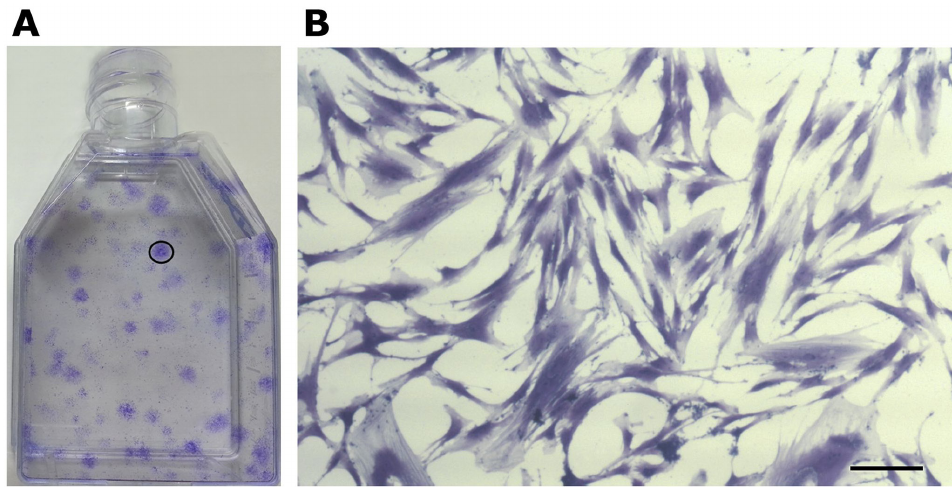
Figure 1. Fibroblast colony-forming unit (CFU-F). Bone marrow cells were plated at low density (100 cells/cm 2 ) and maintained for 3 days in culture. Non-adherent cells were removed and the cultures were maintained for up to 10 days. The colonies were fixed and stained with a solution of 1% crystal violet. (A) Macroscopic aspect of the colonies. The circle indicates one individualized colony; (B) Microscopic aspect of the cells in the colonies. Bar = 50 µ